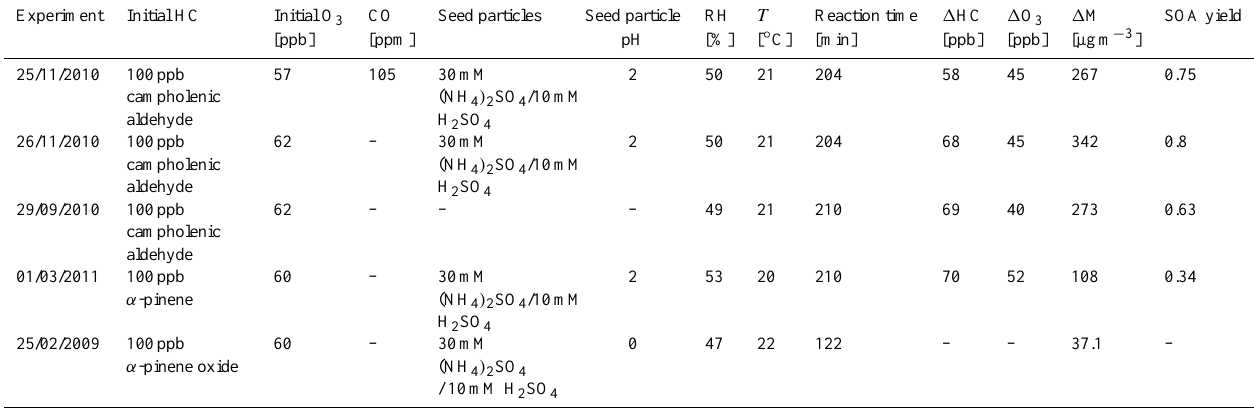
Table 1. Experimental conditions and results for the performed chamber experiments for campholenic aldehyde, α -pinene, and α -pinene